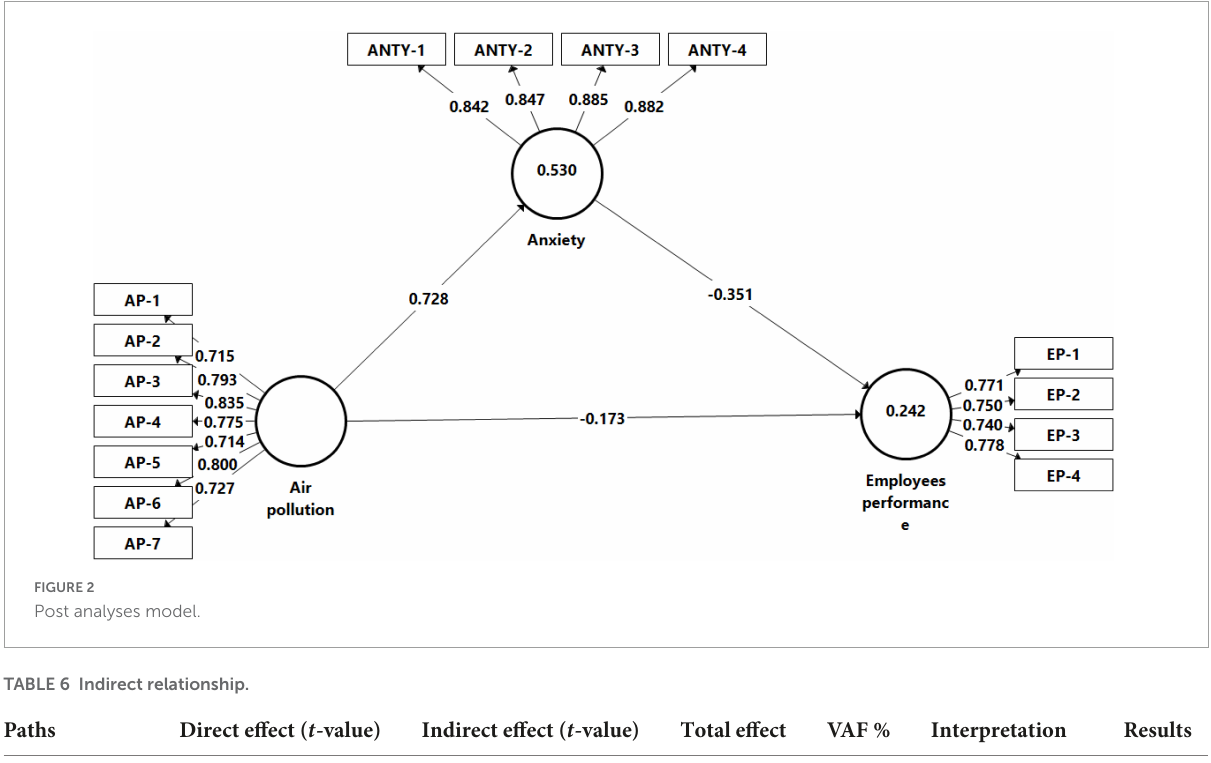
TABLE 6 Indirect